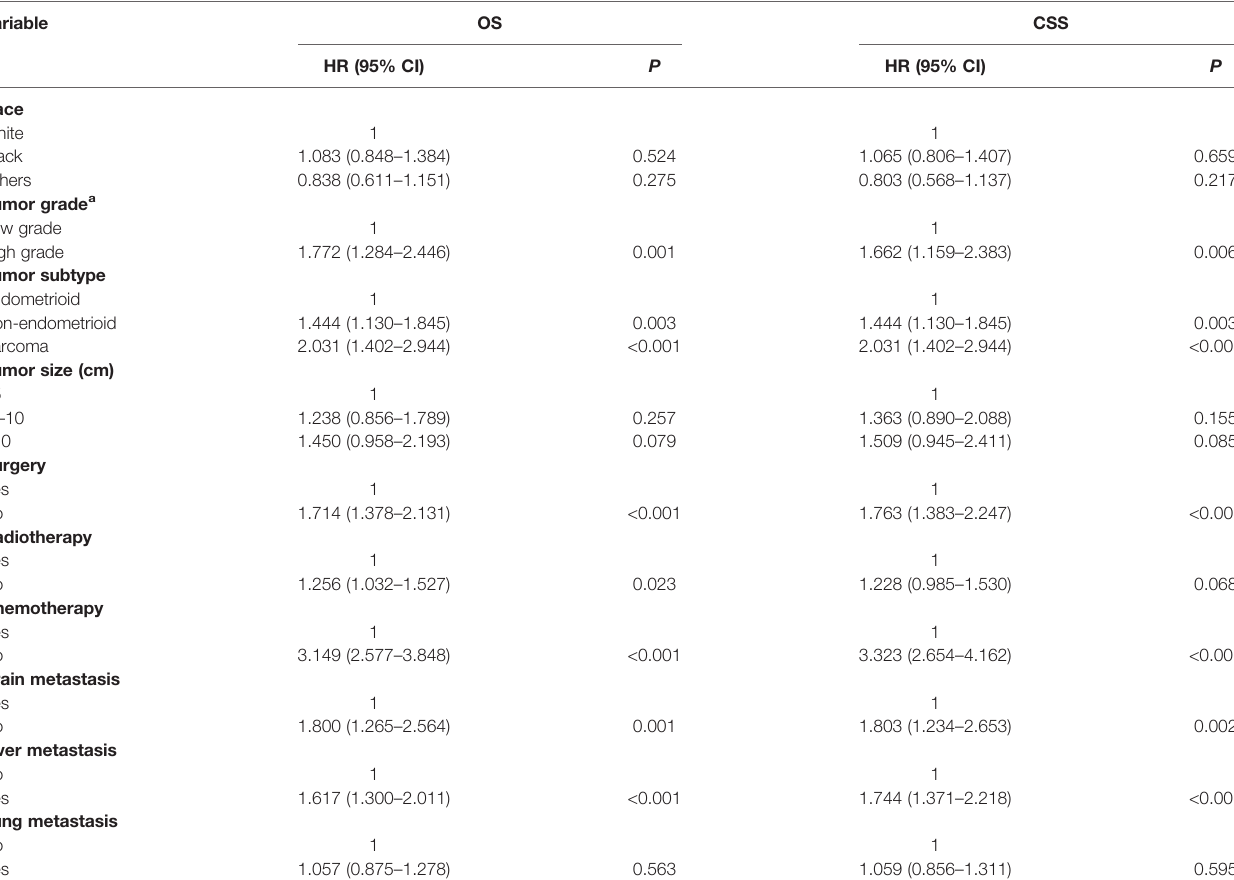
TABLE 3 | Multivariate Cox analysis of variables in endometrial cancer bone